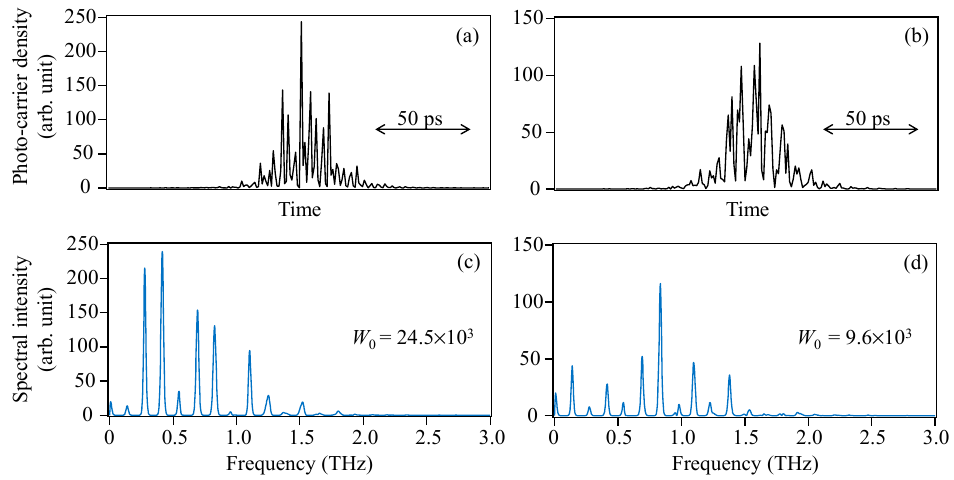
Figure 10. Examples of ( a ); ( b ) single-shot temporal waveforms of the photo-carriers n ( t ) and ( c ); ( d ) the corresponding THz-TDS outputs.